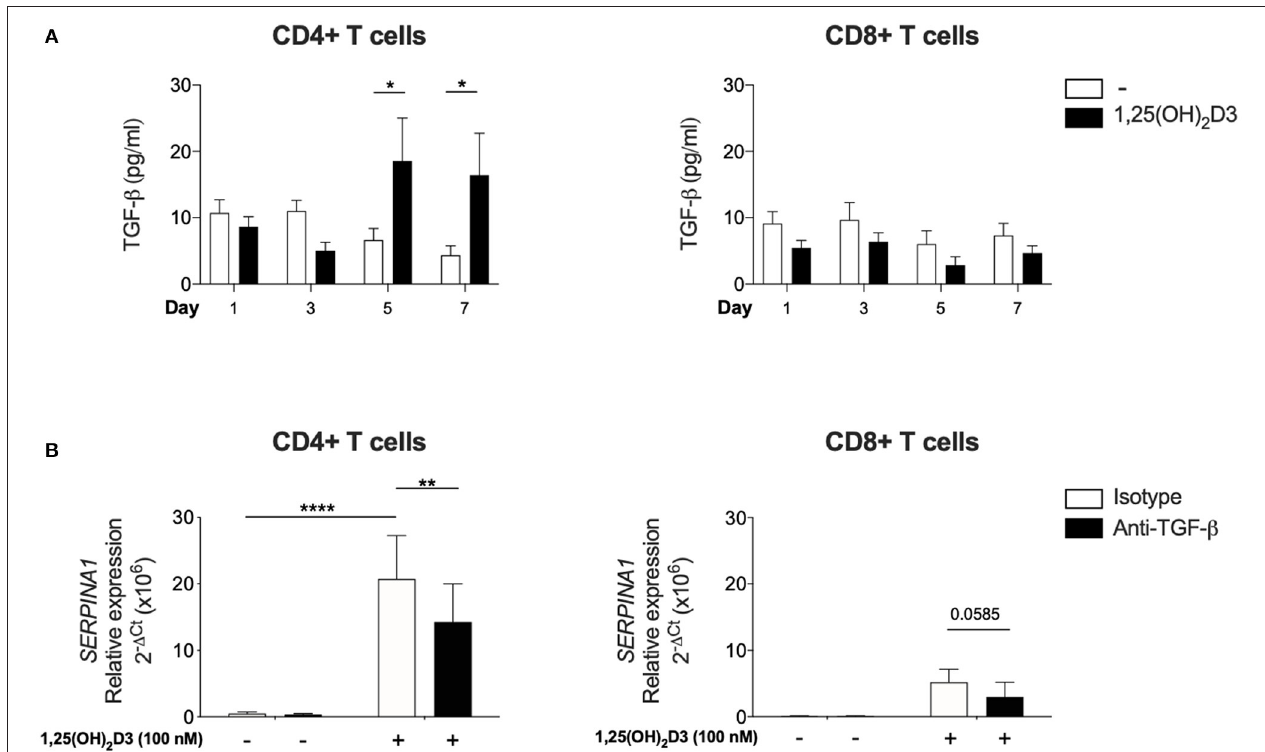
FIGURE 3 | Significant upregulation of bioactive TGF- β is observed with 1,25(OH) 2 D3 treatment in CD4 + T cells and 1,25(OH) 2 D3 induction of SERPINA1 /AAT is partially inhibited by anti-TGF- β . CD4 + and CD8 + T cells ( n = 6) were stimulated and cultured in the absence or presence of 100nM 1,25(OH) 2 D3. (A) Supernatant from indicated time points were harvested and TGF- β bioactivity was measured using transfected mink epithelial lung cells and luciferase activity (luminescence, as relative light unit corresponds to TGF- β bioactivity), and converted to pg/ml. (B) Cells were cultured with 100nM 1,25(OH) 2 D3 in the presence of anti-TGF- β or an isotype control for 7 days. 1,25(OH) 2 D3-mediated induction of SERPINA1 expression was assessed by qRT-PCR. Data are expressed as mean ± SEM and statistical analysis employed a 2-way ANOVA with Bonferroni post-tests with * p < 0.05, ** p < 0.01, **** p <